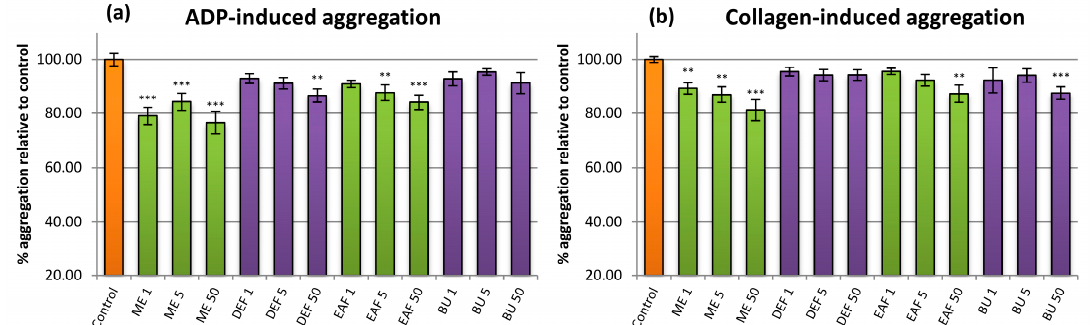
Figure 5. Evaluation of the anti-platelet effects of the examined analytes. The hemostatic response of blood platelets (aggregation in the platelet-rich plasma, PRP) was induced by ( a ) ADP and ( b ) collagen. Results presented as means ± SE ( n = 11). Statistical differences: ** p < 0.01, *** p < 0.001 for control platelets versus platelets incubated with analytes. Analytes: ME—methanol extract; DEF—diethyl ether fraction; EAF—ethyl acetate fraction; BF— n -butanol fraction; number after analyte symbol indicate concentration in μ g/mL.